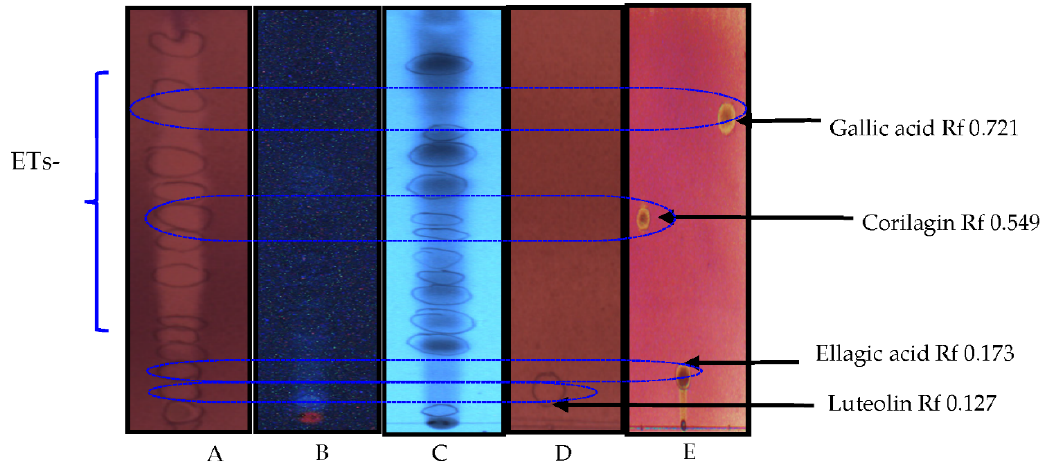
Figure 2. Thin-layer chromatograms (RP 18-TLC) of an ethyl acetate extract (EtOAc) of the leaves of Terminalia brownii ( A – C ) and standard compounds ( D , E ). The chromatograms were imaged after treatment with the DPPH reagent ( A , D , E ) at 366 nm ( B ); at 254 nm ( C ). Rf = retardation factors for the standard compounds. ETs, ellagitannins.